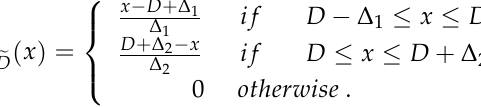
Figure 4. The Fuzzy Membership Function (FMF) of (cid:101) D is formulated as